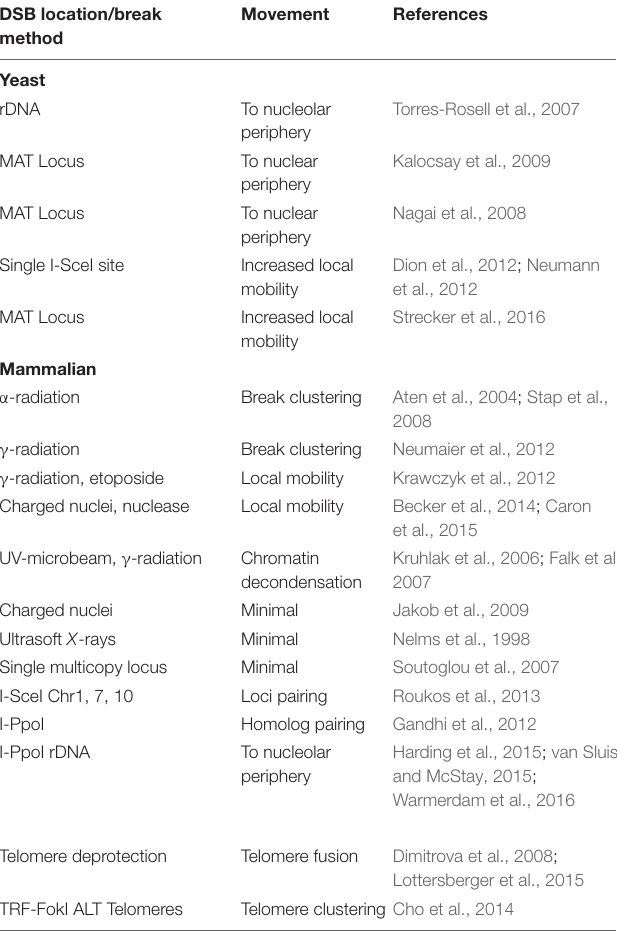
TABLE 1 | Large-scale movement following double strand breaks